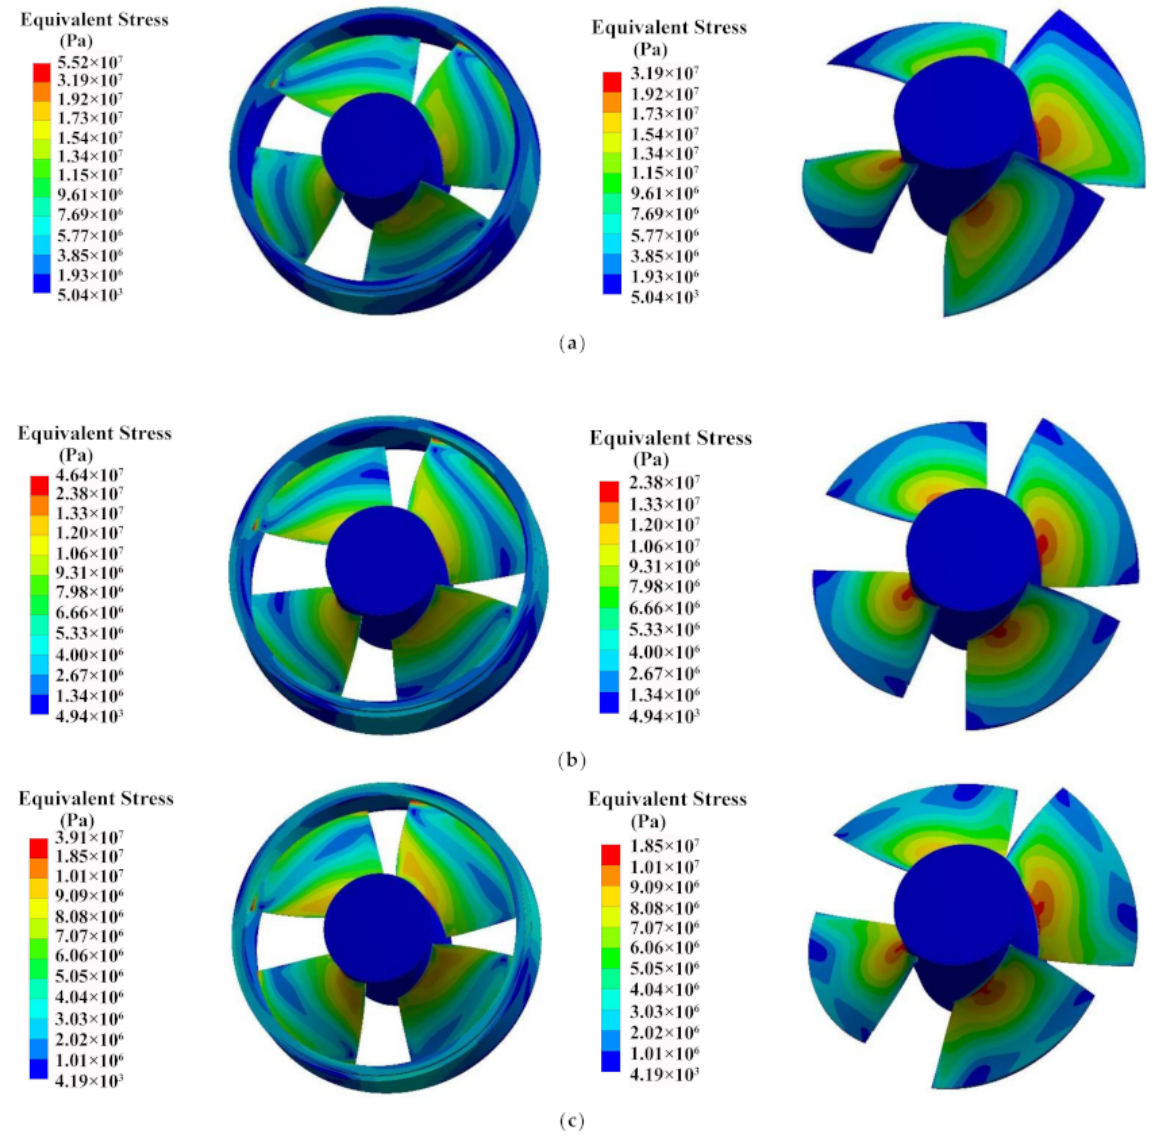
Figure 11. Equivalent Stress distribution of the blade PS between the full tubular pump and axial-flow pump: ( a ) the equivalent stress under 0.8 Q bep , ( b ) the equivalent stress under Q bep , ( c ) the equivalent stress under 1.1 Q bep